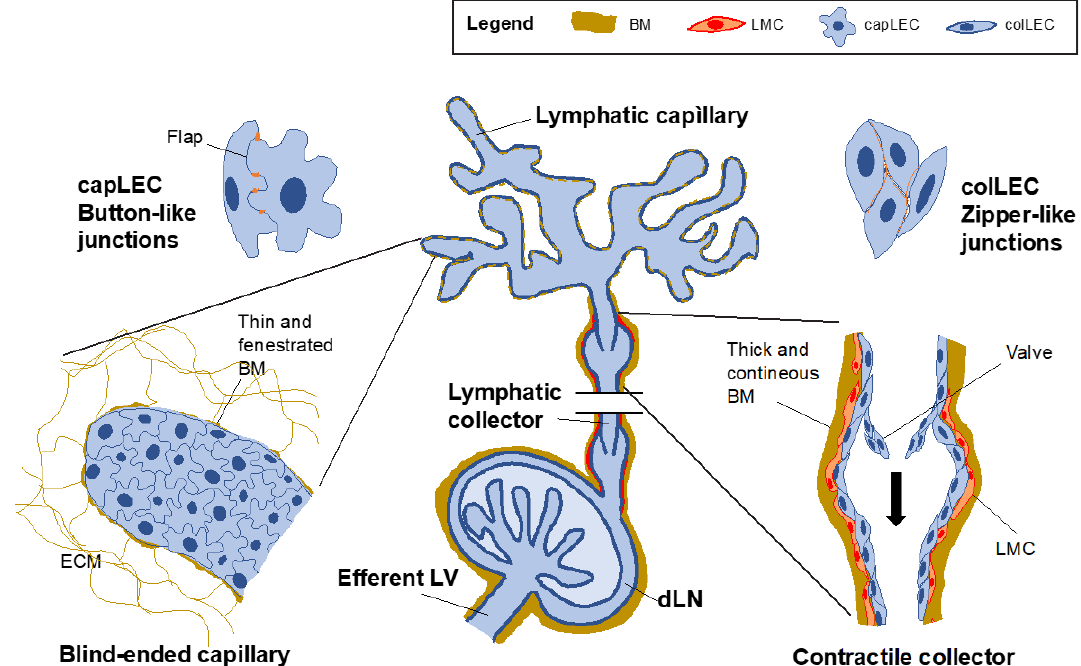
Figure 1. Morphological and anatomical characteristics of afferent lymphatics. Afferent LVs begin as blind-ended initial capillaries in peripheral tissues. Lymphatic capillaries have a wide lumen and are surrounded by a thin and fenestrated basement membrane (BM). LECs in lymphatic capillaries (capLECs) have a characteristic oak-leaf shape and are attached to each other by discontinuous button-like junctions, thereby generating open flaps (primary valves). capLECs are connected to the interstitial extracellular matrix (ECM) via anchoring filaments, allowing the flaps to open when interstitial fluid pressure increases. This characteristic setup, together with the discontinuous BM render initial capillaries specialized structures for fluid uptake and leukocyte intravasation. Lymphatic capillaries subsequently merge into lymphatic collectors, which eventually connect to dLN. Contrary to capillaries, LECs in collectors (colLECs) are elongated in the direction of flow and are attached to each other by continuous zipper-like junctions. Collecting vessels are also surrounded by a thick and continuous BM and covered by a layer of lymphatic muscle cells (LMCs). This setup, together with the presence of intralymphatic valves, allows lymphatic collectors to periodically contract and expand, thereby generating flow and propagating lymph in the direction of the dLN. Efferent LVs exit from LNs and connect with subsequent LNs to eventually merge into the thoracic and right lymphatic